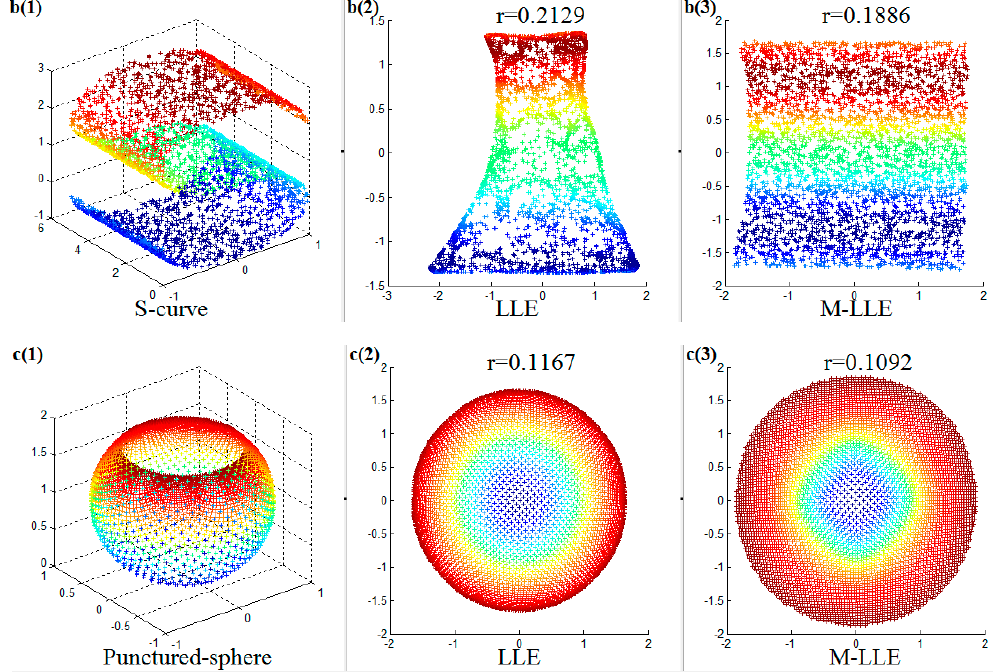
Figure 3. The dimensionality reduction effect of M-LLE algorithm in noiseless artificial data set.